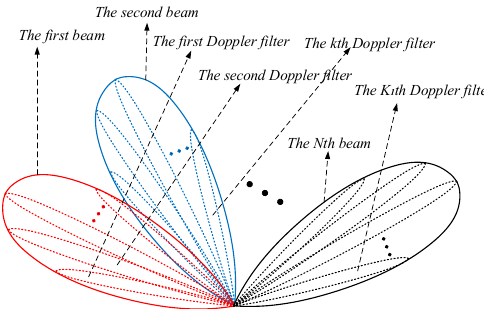
Figure 2. Beam scanning and fine Doppler